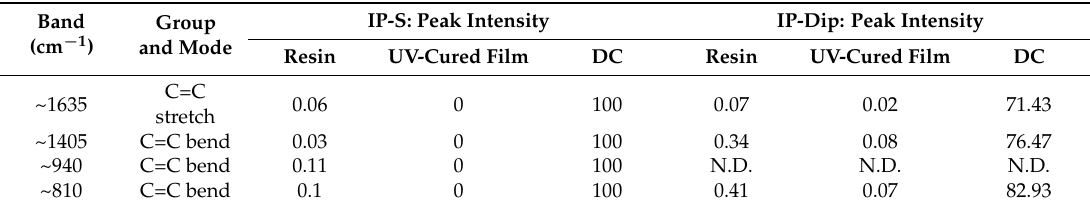
Table 3. Summary of FTIR peak intensities (normalized to the C=O peak) for CH 2 =CH- stretching and bending vibrational